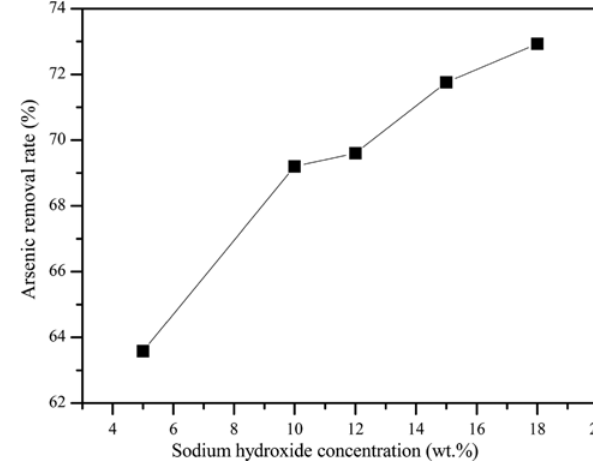
Figure 1: XRD pattern of arsenic-bearing gold ore.